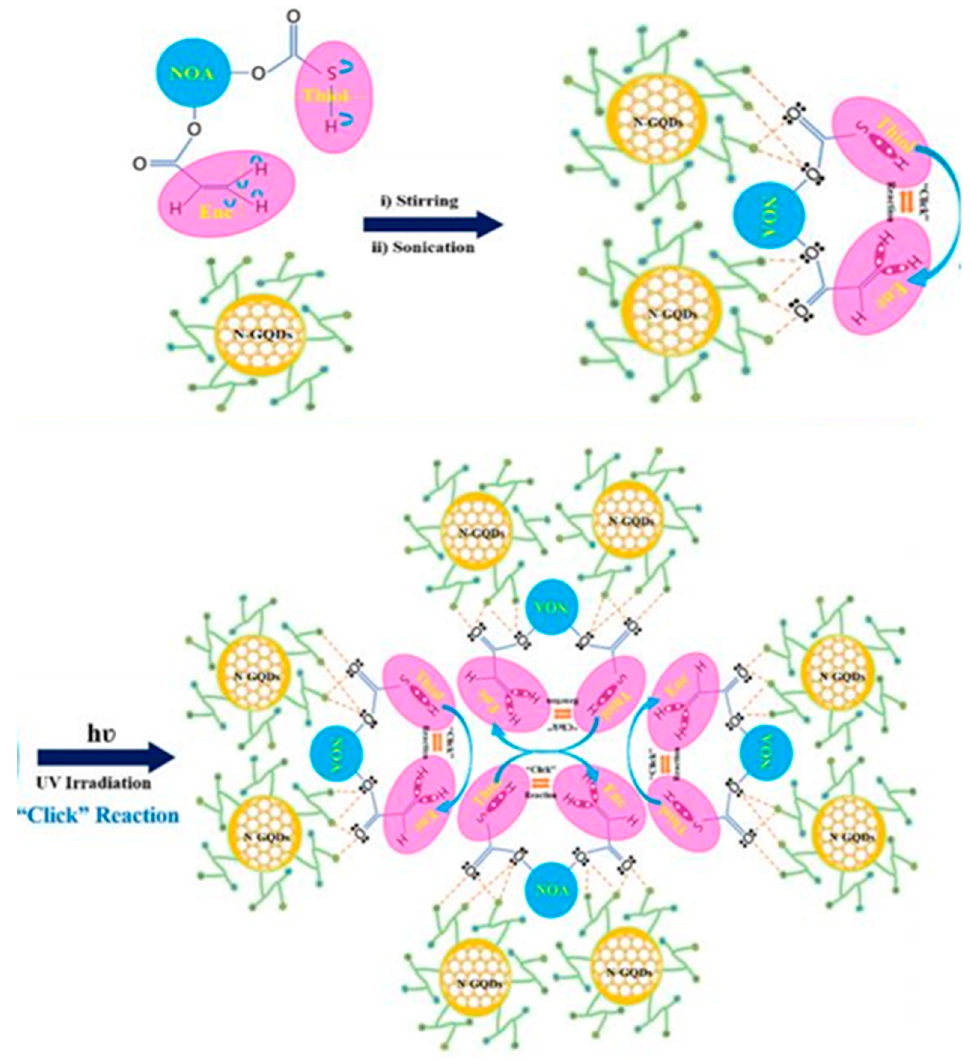
Figure 10. Model of the thiol − ene “click” reaction pathway of NOA polymers with N-GQDs [69].